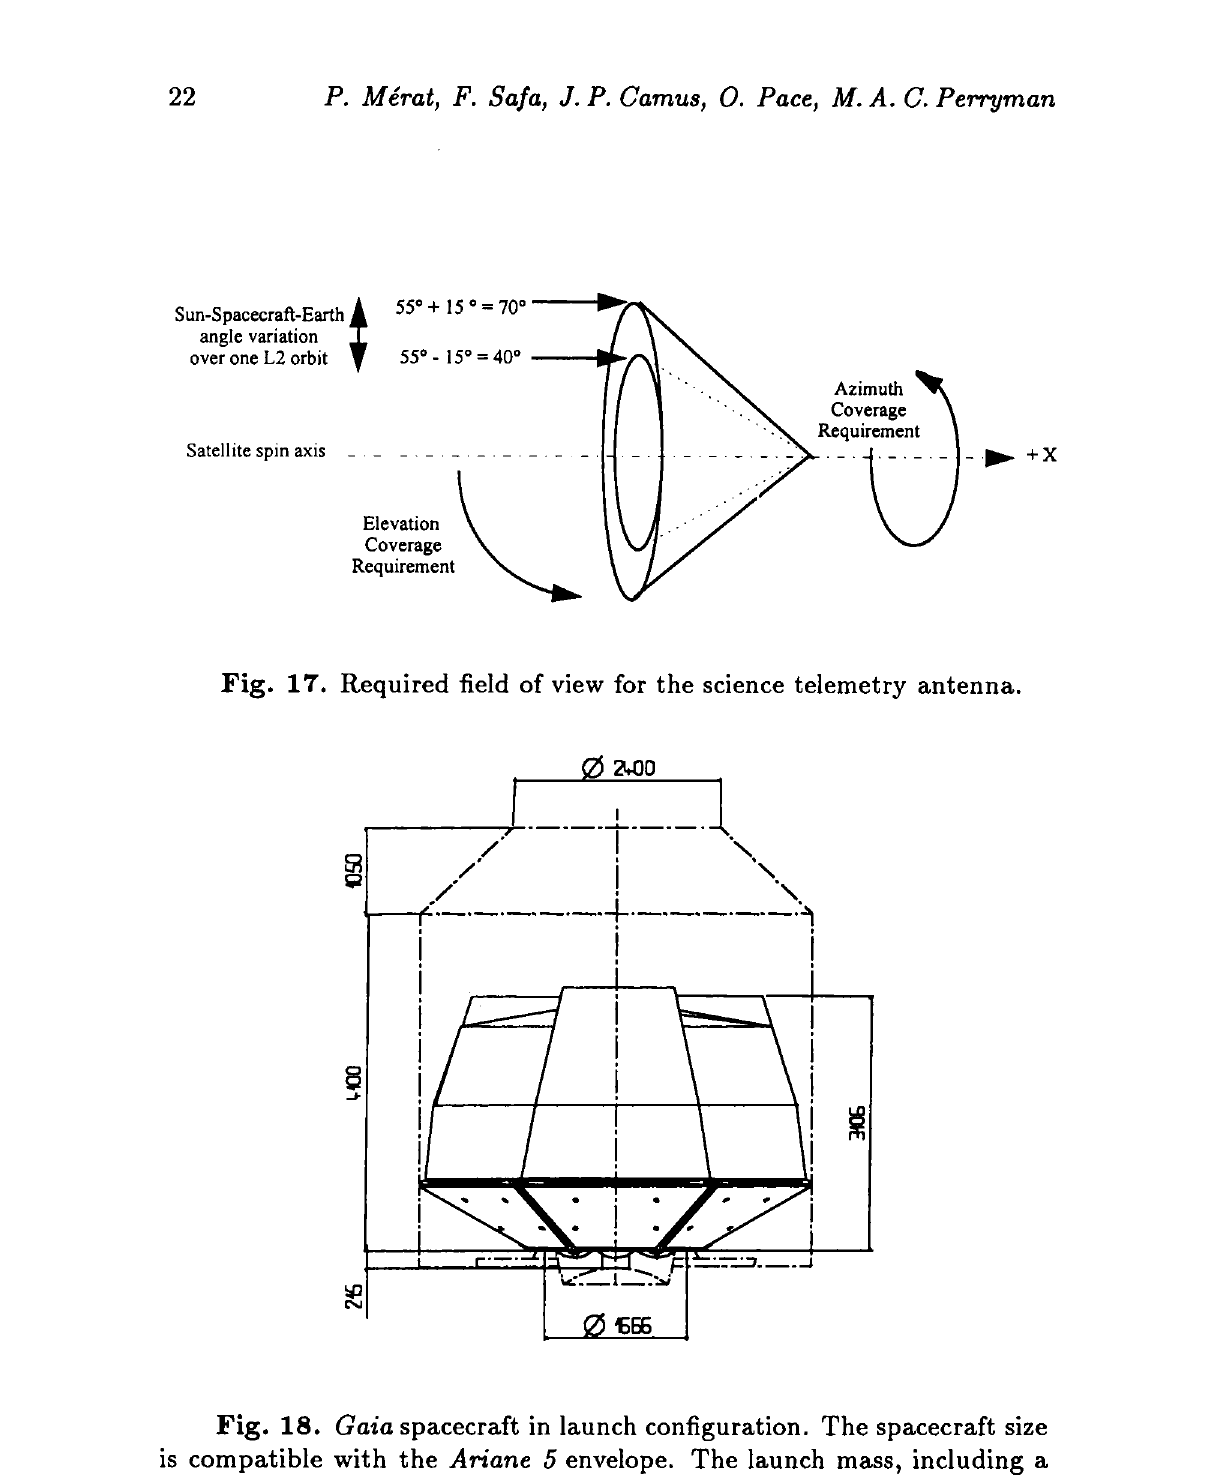
Fig. 18. Gaia spacecraft in launch configuration. The spacecraft size is compatible with the Ariane 5 envelope. The launch mass, including a design margin, is close to 3